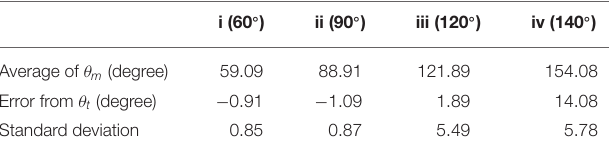
TABLE 1 | Measurement results of self-folded angle θ m